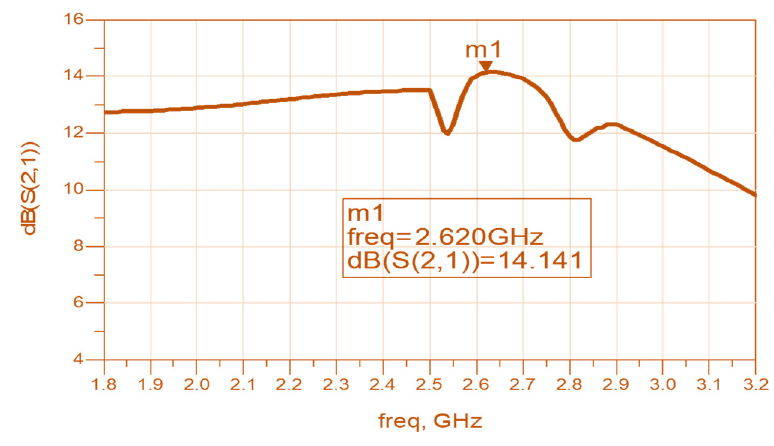
11 of 30 Figure 10. Measured S11 of the Circular polarized active receiving antenna.